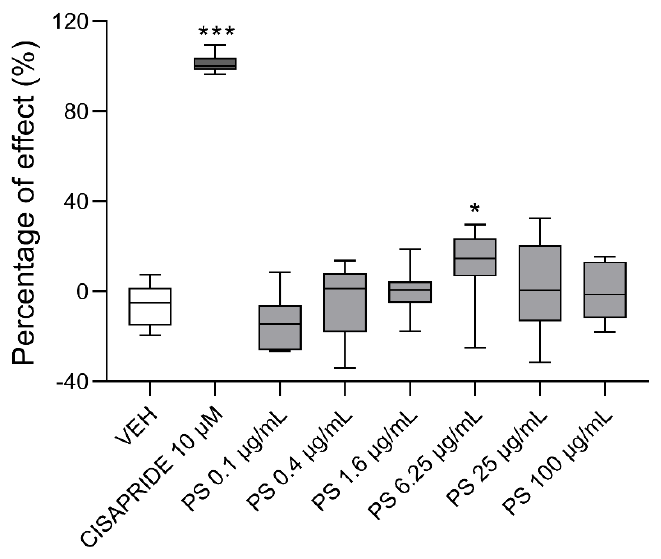
Figure 14. The effects of protamine sulfate (PS), vehicle (VEH), and cisapride on hERG K + currents. Data are shown as medians (line) with interquartile ranges (box) and maximum and minimum values (whiskers). Note: * p < 0.05, *** p < 0.001 vs. VEH, Kruskal–Wallis ANOVA with Dunn’s post–hoc, n = 6–15 in each concentration.